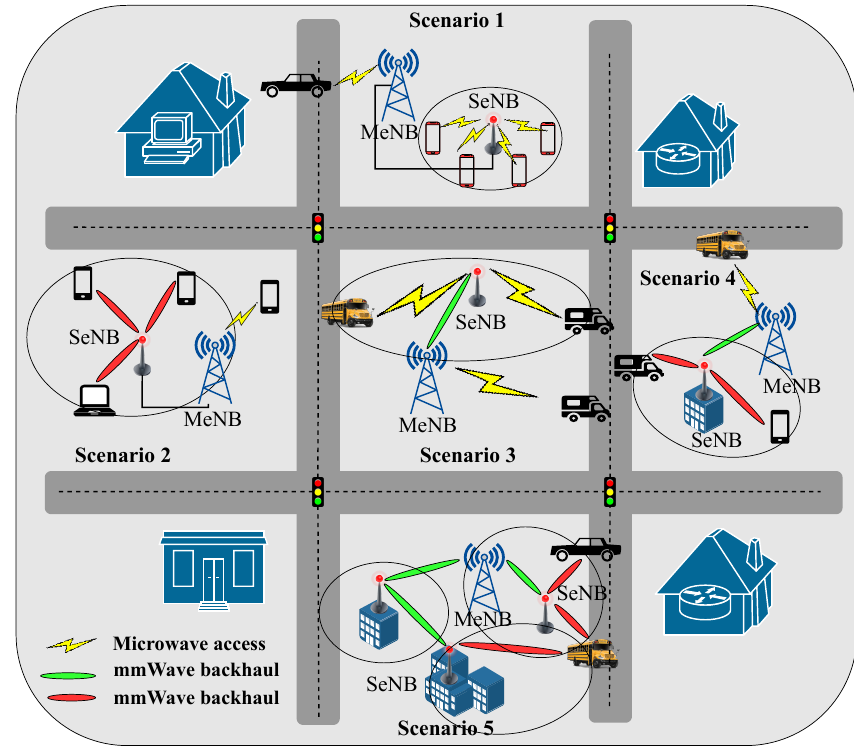
Figure 7. Architecture of